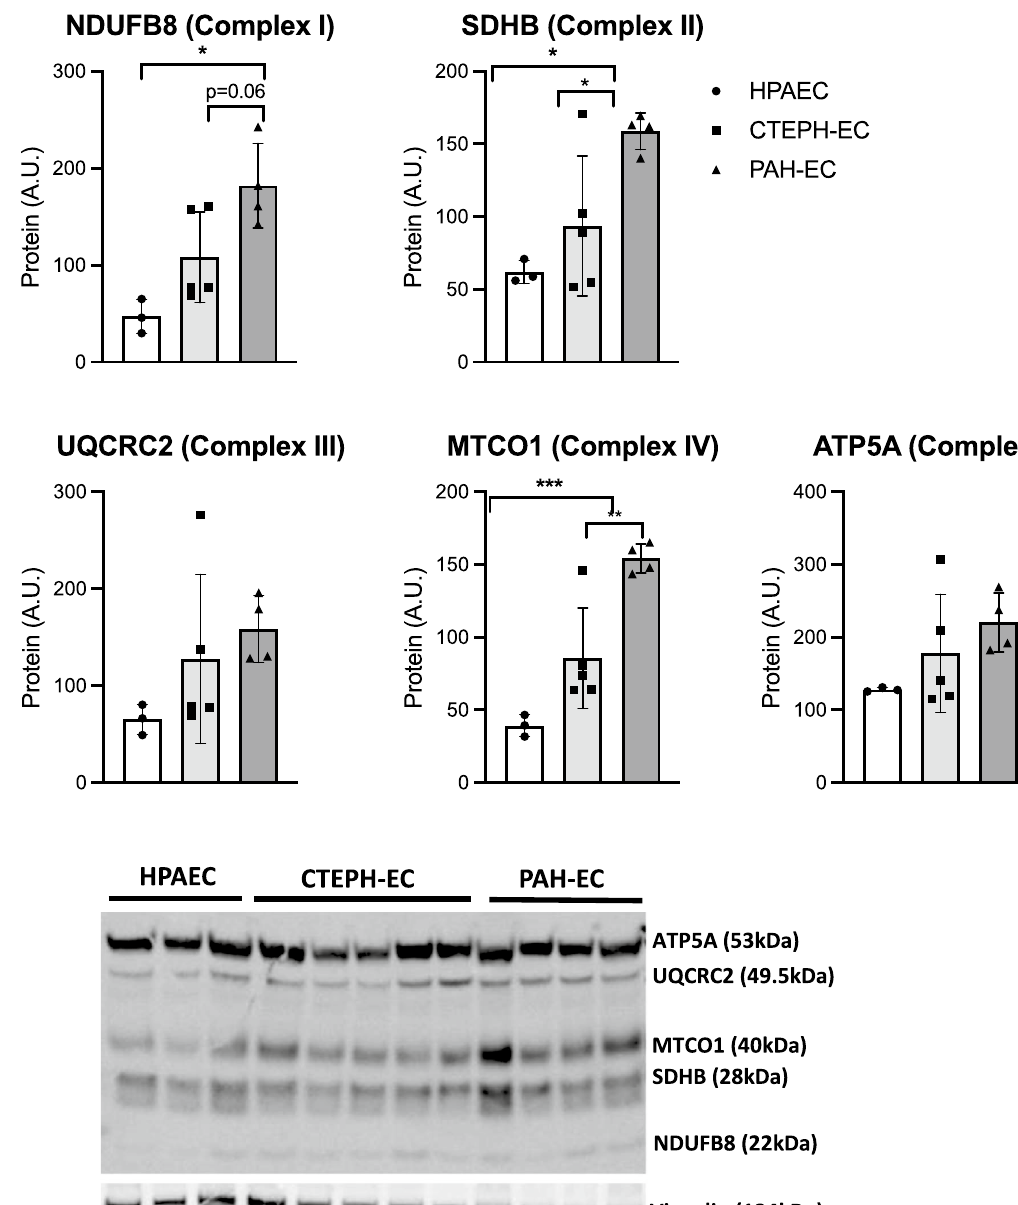
Figure 4. Oxidative associated protein expression. Protein levels of complexes-I, -II and -IV were found significantly upregulated in PAH-EC compared to CTEPH-EC. All three complexes are also significantly different between PAH-EC and HPAEC. Similar levels were observed for complexes-III and -V between all three groups studied. CTEPH-EC, n = 5; PAH-EC, n = 4; HPAEC, n = 3; One-way ANOVA, data is expressed as mean ± SD, p < 0.05 = *; p < 0.01 = **; p < 0.001 = ***. Statistical analysis was performed with GraphPad Prism 7 software, version 7.0e, serial number:GP7-0,633,739-R###-#####,https:// www. graph pad. com. (full-length gels are presented in supplementary material Fig.